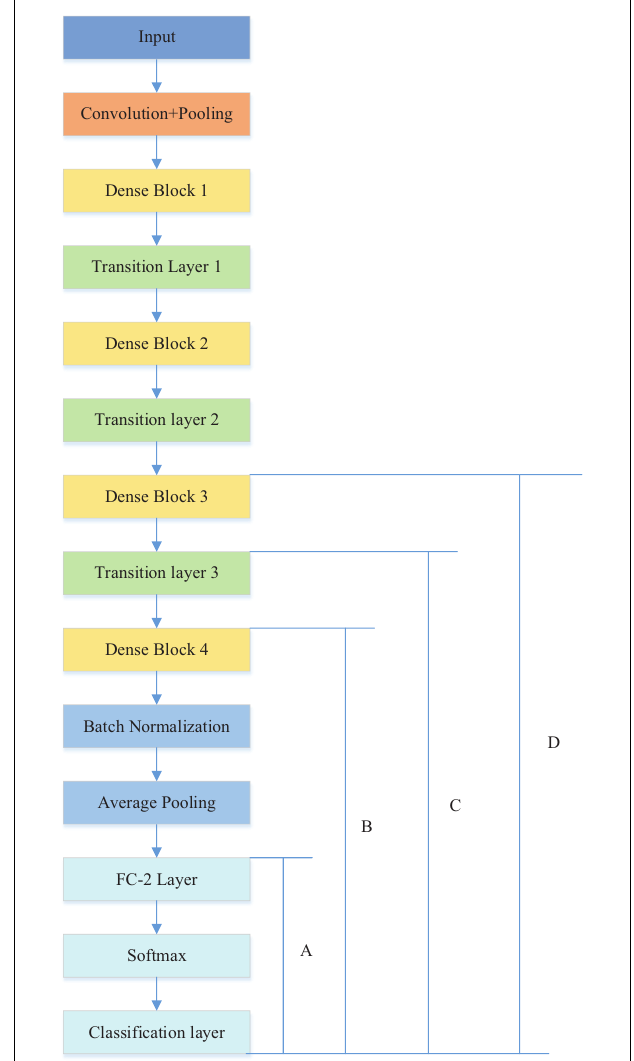
FIGURE 8 | Different cases of transfer learning (the original fully connected layer with 1000 neurons was replaced by a new fully connected layer with 2 neurons).